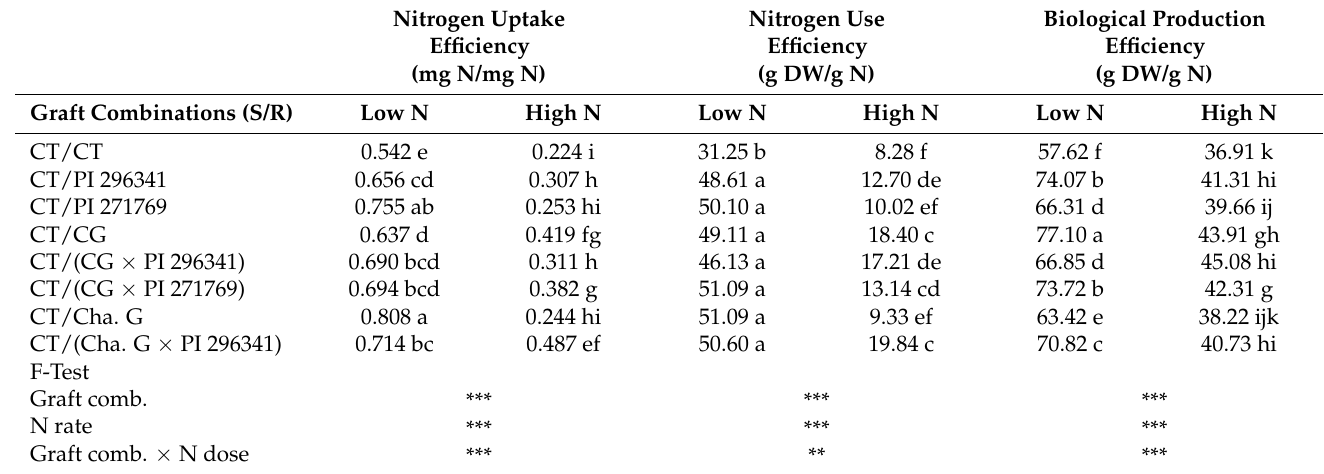
Table 3. Nitrogen uptake, nitrogen use, and biological production efficiencies of self-grafted and grafted watermelon cultivars grown under low N dose (0.3 mM) and (3.0 mM) high N dose. Nitrogen Nitrogen Uptake Efficiency (mg N/mg N)